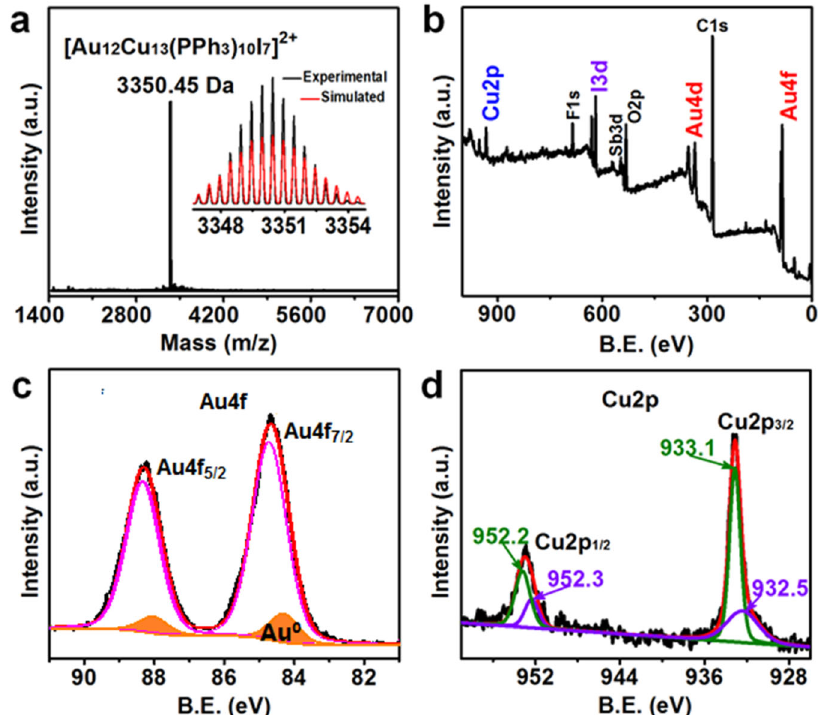
Fig. 2 Physical property of the Au 12 Cu 13 nanocluster. a ESI-MS with isotopic pattern (insert). b Wide scan XPS. c Au 4 f and d Cu 2p XPS spectra of Au 12 Cu 13